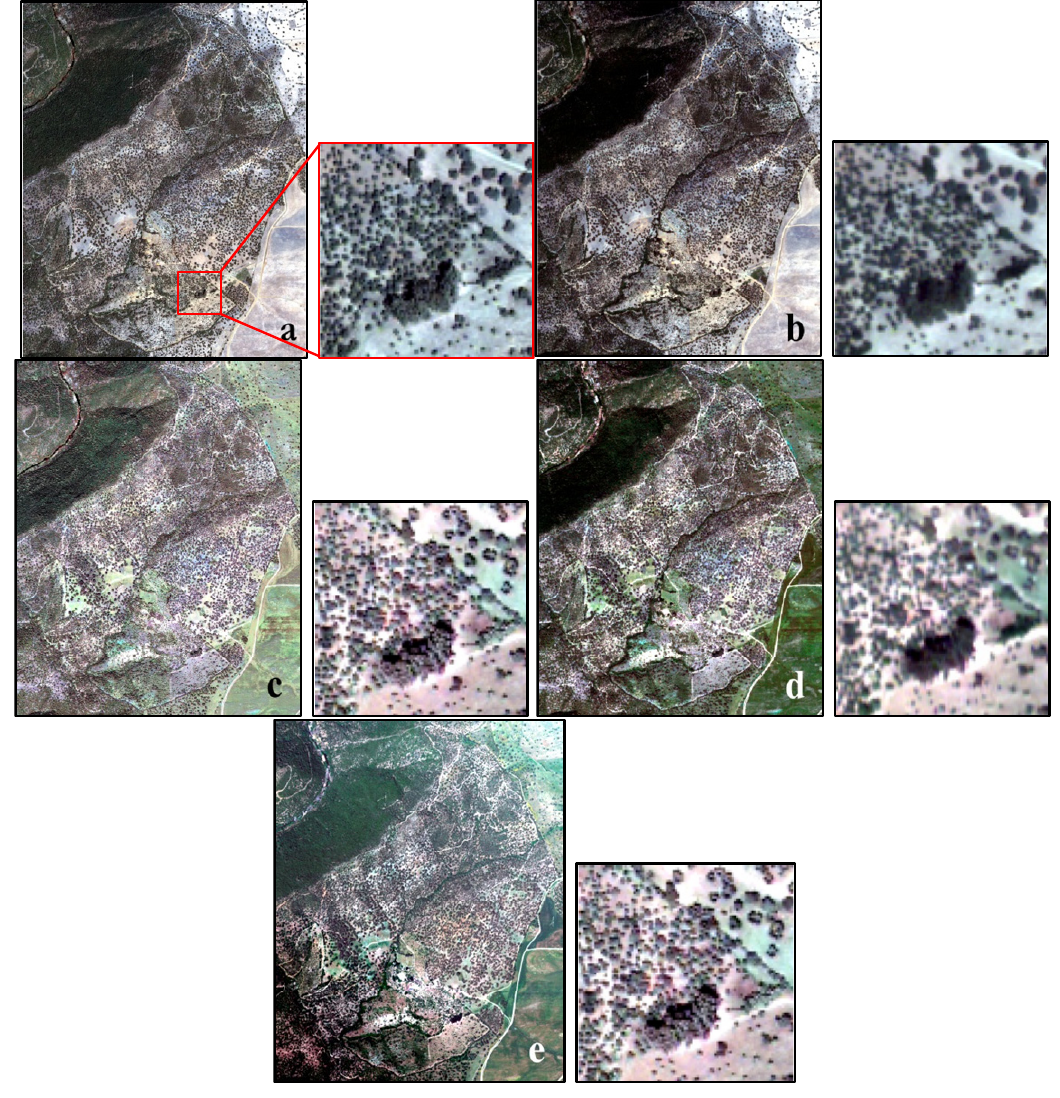
Figure 3. Comparison between images with different spatial resolution: ( a ) QuickBird 2008 Fused (60 cm); ( b ) QuickBird 2008 Non-fused (240 cm); ( c ) QuickBird 2009 Fused (60 cm); ( d ) QuickBird 2009 Non-fused (240 cm); and ( e ) Flight 2009 (240